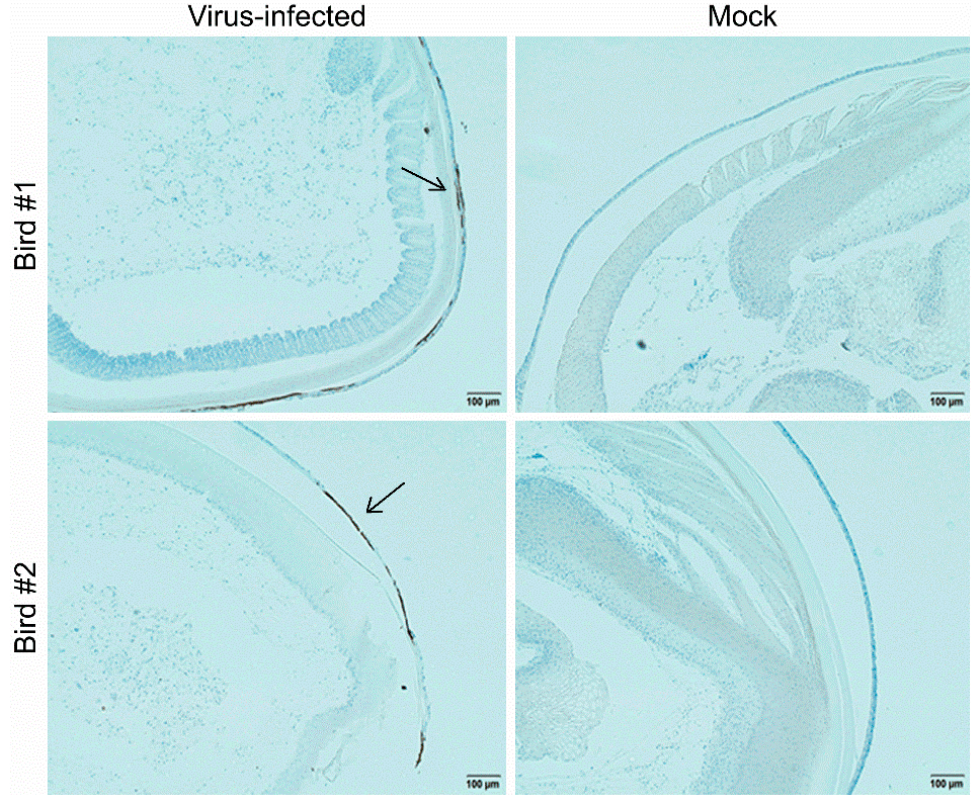
Figure 8. Expression of pp38 proteins in the feather follicle epithelium of MDV-infected birds, as determined by immunohistochemistry. The feather follicular samples from Md5-challenged birds at 14 days post-infection were subjected to immunohistochemistry analysis using the pp38 mAb 31G7. The black arrows indicate MDV-expressed pp38 proteins in the feather follicle epithelium. Scale bar = 100 µm.